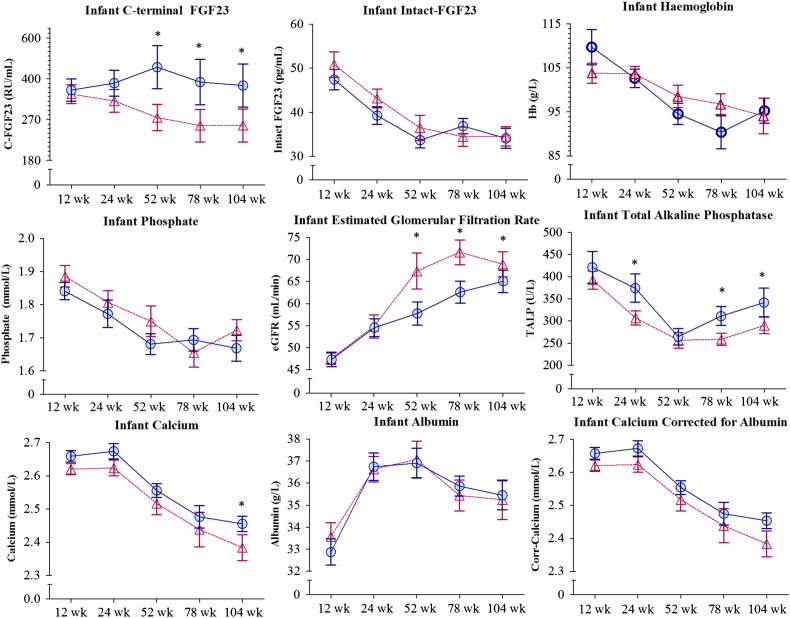
Infant biochemistry. Infants selected based on maternal soluble transferring receptor (sTfR mg/L)/log ferritin (Ferr μg/L) index at 20 wk gestation: sTfR/log Ferr > 2.0 = Low Iron (blue circles), sTfR/log Ferr < 1.5 = Normal Iron (pink triangles). * indicates a significant difference between groups (P < 0.05) using least-squares post hoc tests as in Table 4.